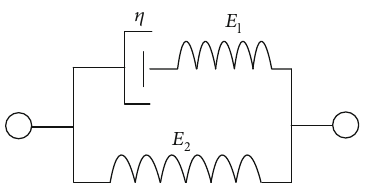
Figure 1: Schematic illustration of standard linear solid (SLS) model.